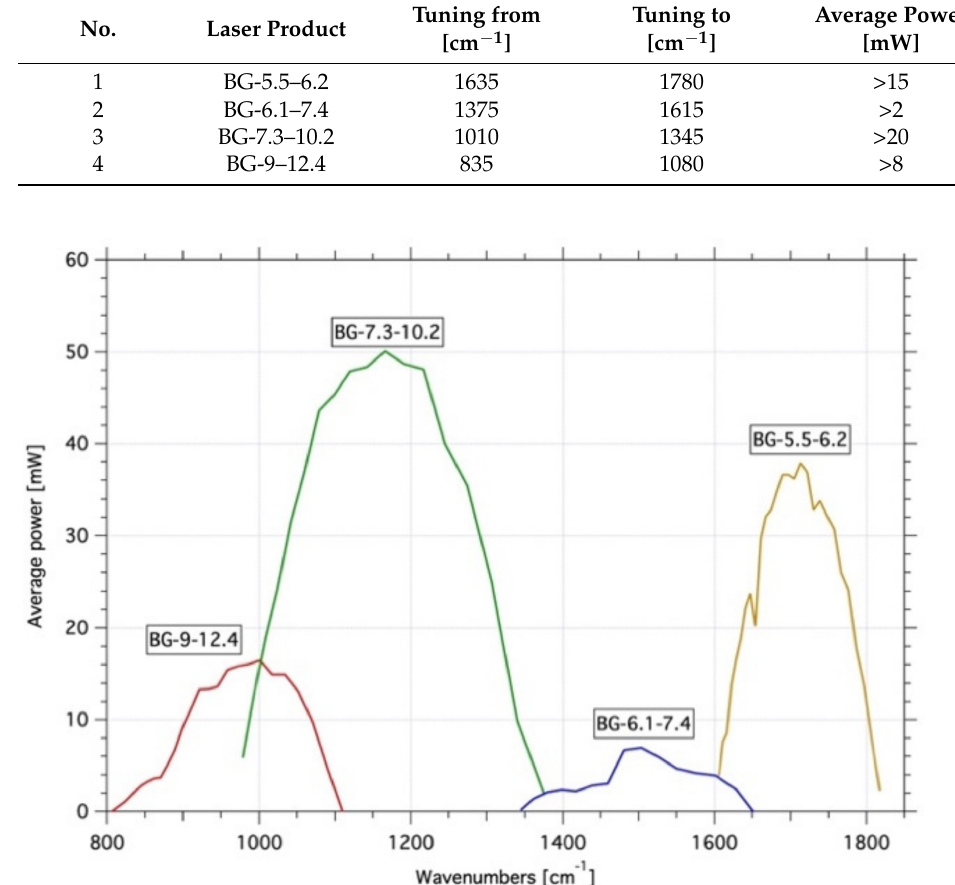
Figure 9. Tuning curves of the four lasers of the proposed active illuminators for Mid